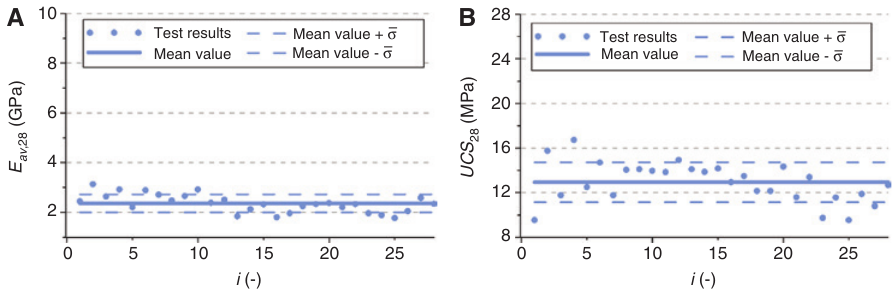
Figure 16: The results of successive uniaxial compression tests for gypsum samples ( D = 28 mm). (A) variation of Young modulus and (B) variation of UCS